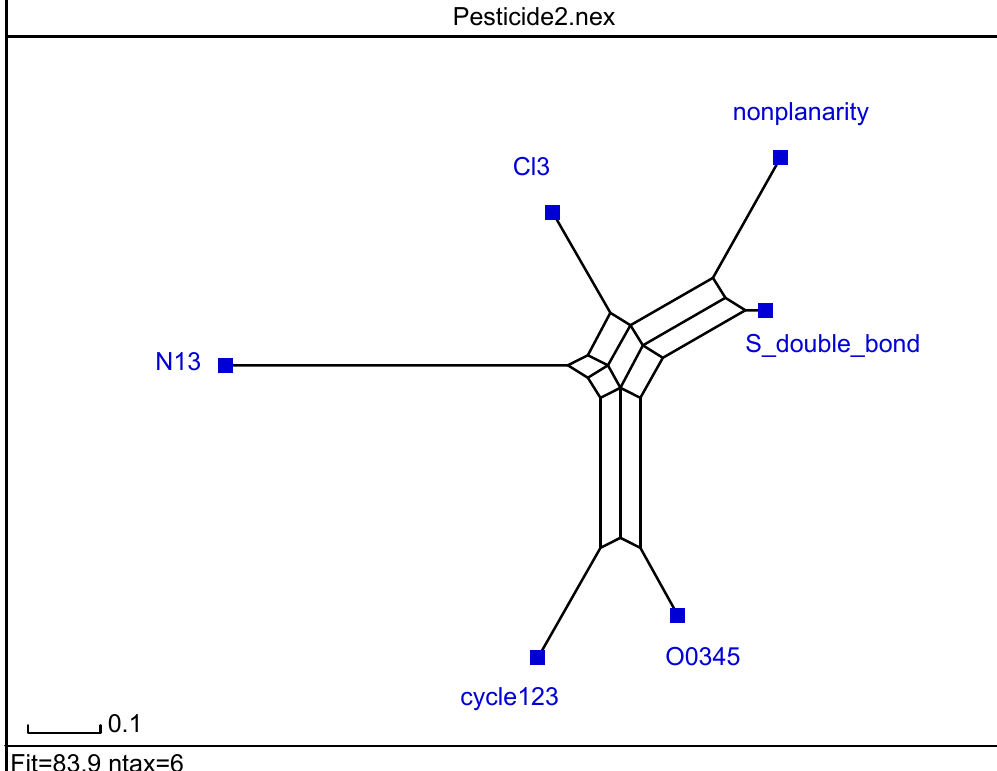
Figure 9. Splits graph for the vector properties corresponding to the pesticides.